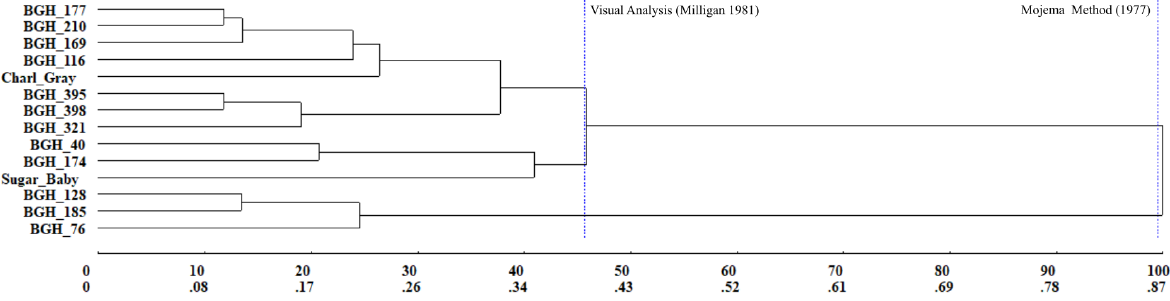
Figure 1. Dendrogram obtained by clustering analysis of the farthest neighbor, based on the sum of the dissimilarity matrices obtained by the standardized Euclidean mean distance for the variables of 12 accessions of watermelon plus the cultivars Sugar Baby and Charleston